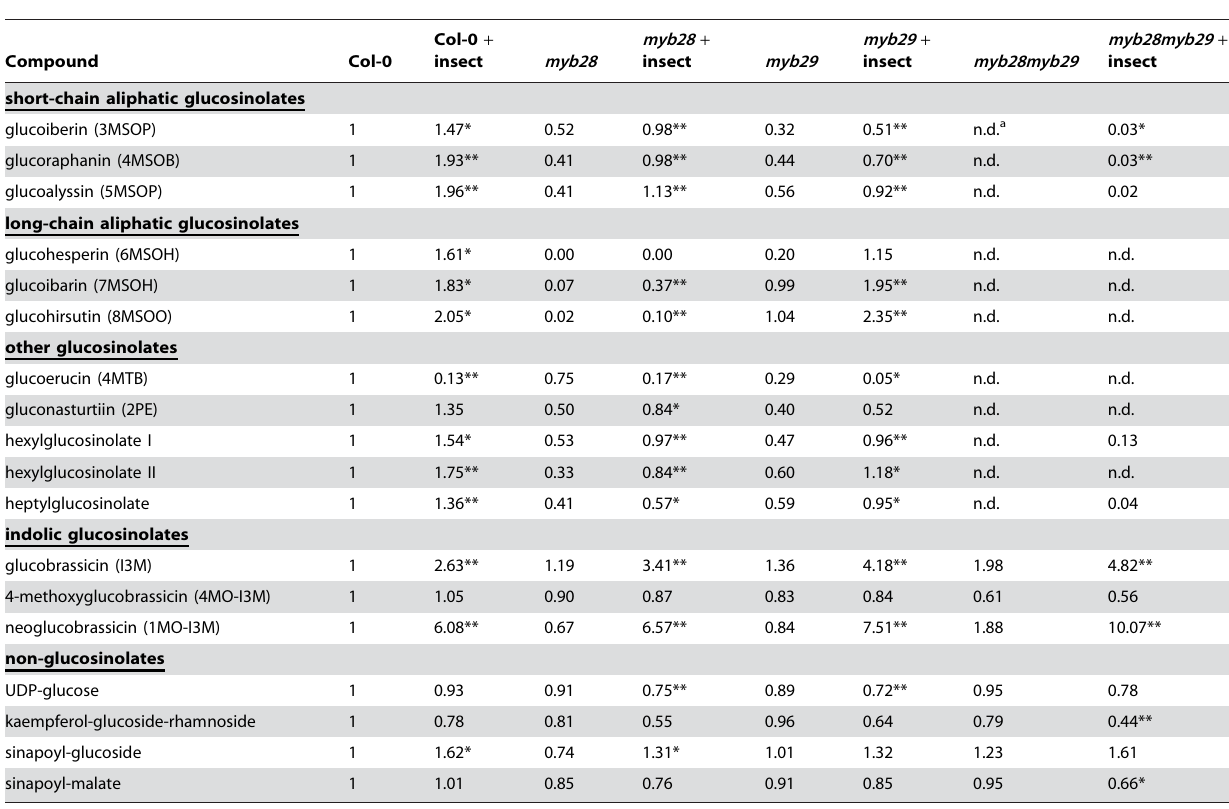
Shown are ratios of the mass signals relative to those in control Col-0. The significance (n=4) of concentration change due to insect feeding within the same plant line is